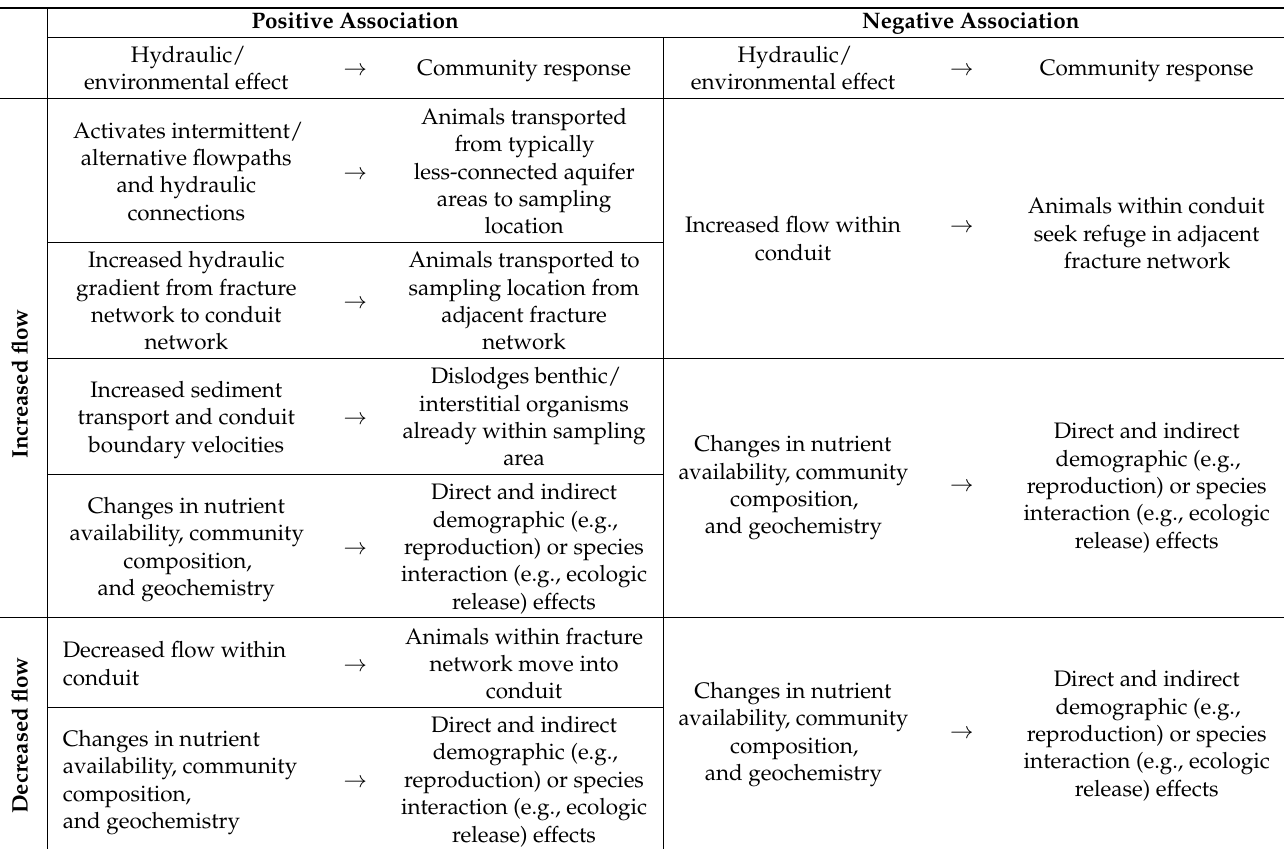
Table 2. Potential mechanisms by which hydraulic changes affect stygobiont assemblage composition in deep phreatic